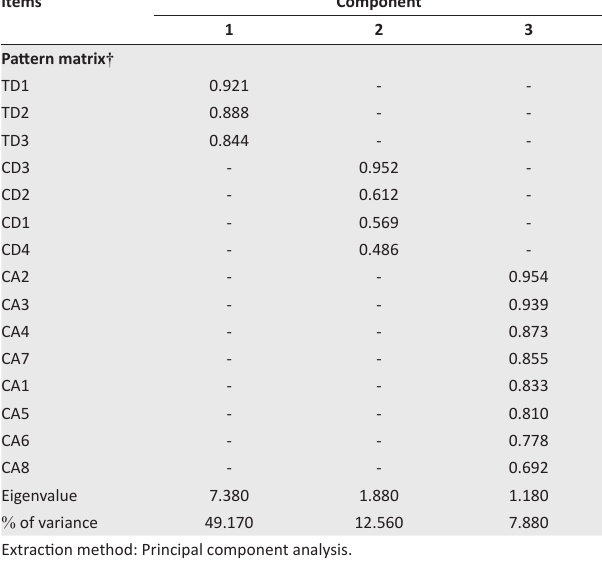
TABLE 2: Factor analysis.